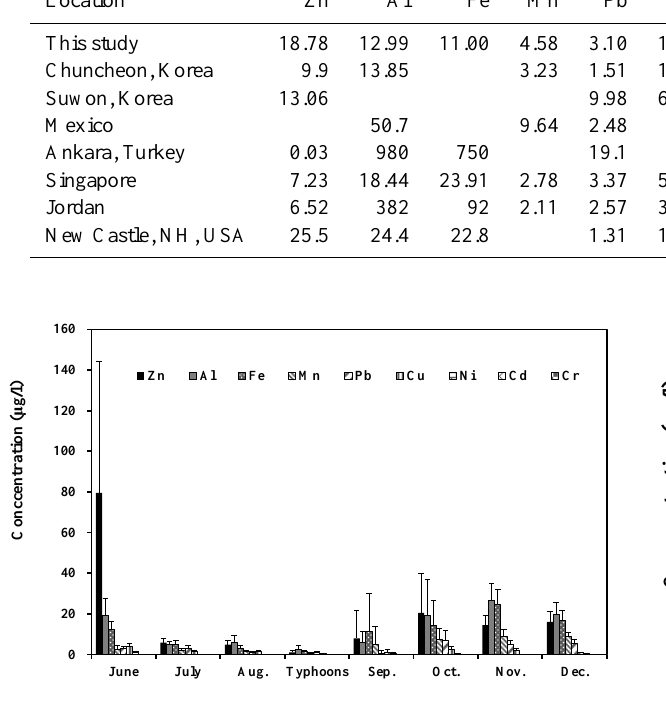
Figure 8. Mean concentration of trace metals in